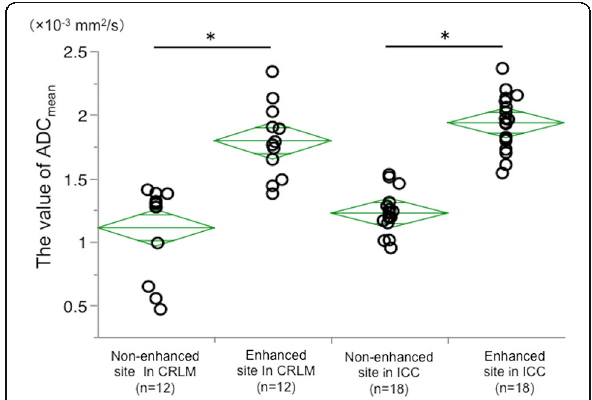
Fig. 4 The average values of ADC mean in six ICCs (18 area) and four CRLMs (12 area) were significantly different between the degenerate and the non-degenerate areas ( t test, p < 0.0001). Asterisk denotes p <